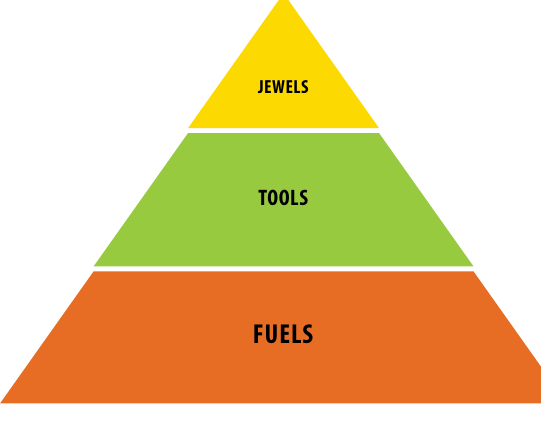
Fig. 1. Maslow’s Hierarchy of needs (1943) Fig. 2. Hierarchy of